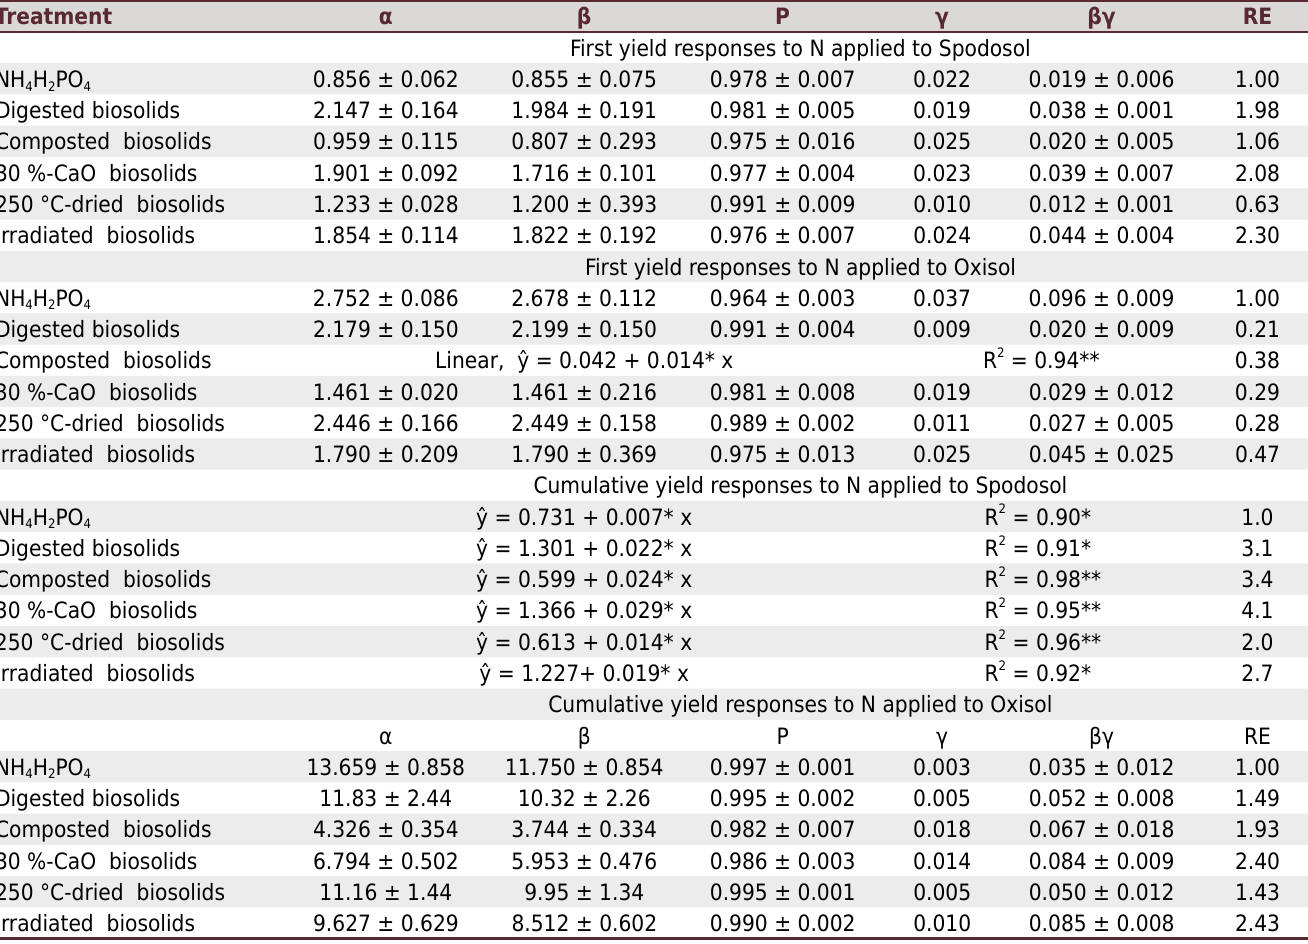
Table 5. Coefficients for yield responses to the treatments fitted to either asymptotic regression models (ŷ = α – β Ρ X ) or linear regression model (ŷ = α + β 1 x) for the first and six cumulative harvests